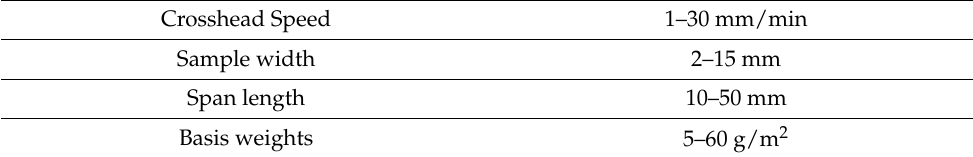
Table 1. Range of various protocols for CNF tensile strength testing.